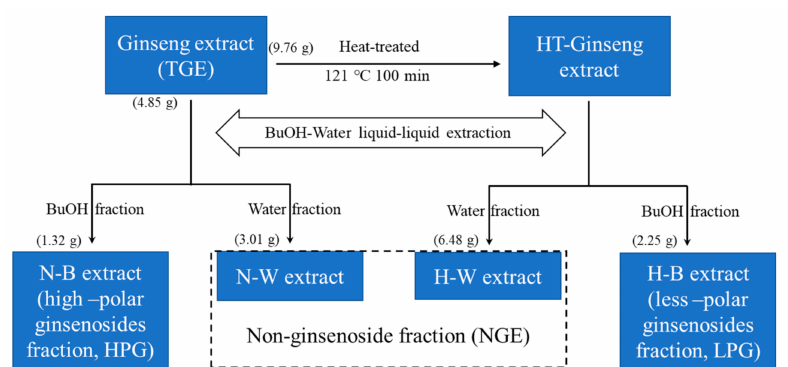
Figure 6. The flow chart of preparation of ginseng extract